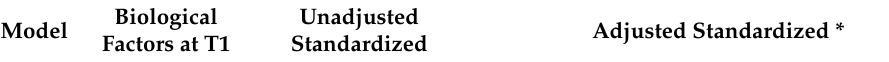
Table 4. Multivariate models of predictive biomarkers of anemia at third trimester of pregnancy (T3) in the matched nested case–control sample, using conditional logistic